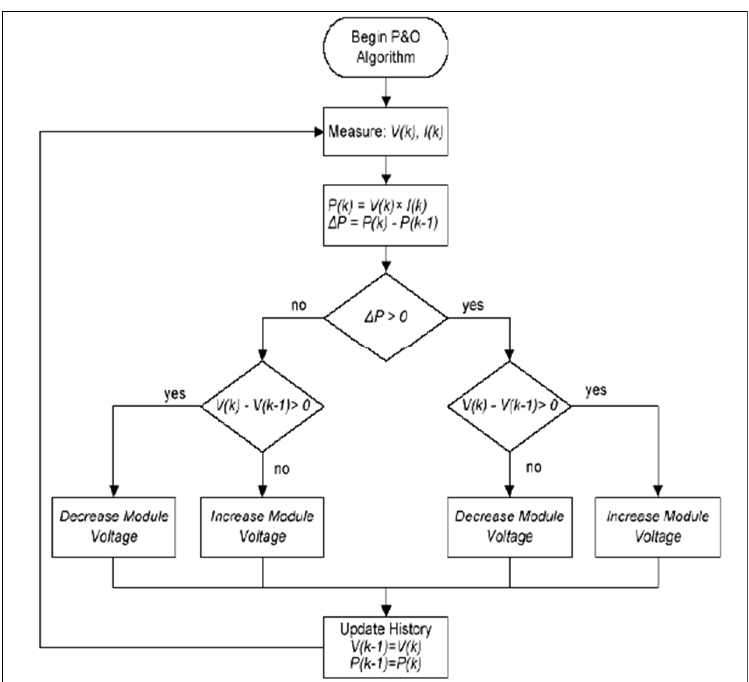
Fig. 6 Flow Chart of (P&O) algorithm used in our MPPT charge controller